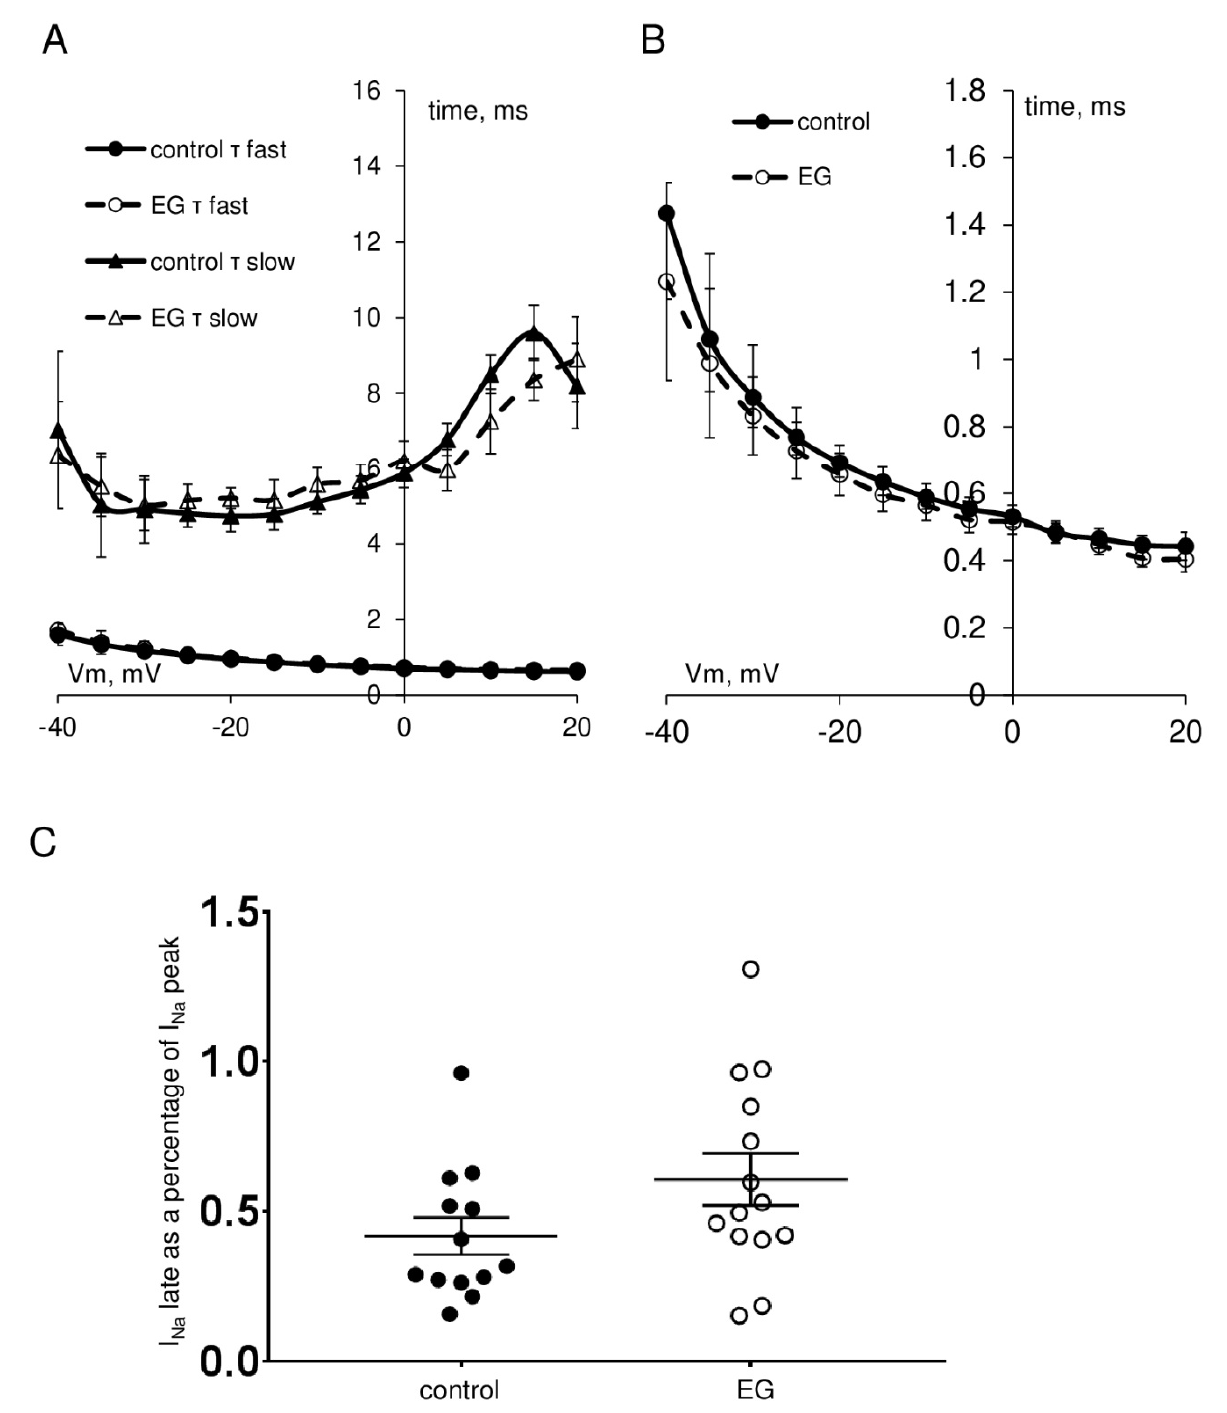
Figure 3. ( A ) The voltage dependence of the inactivation fast (triangles) and slow (circles) time constants τ fast , τ slow of I Na in control (filled) and after 2 h incubation with 5 µ M empagliflozin (open) cardiomyocytes. ( B ) The voltage dependence of the time to peak of I Na . ( C ) Grouped data on I Na late current as a percentage of I Na peak current in control and after 2 h incubation with 5 μ M empagliflozin.